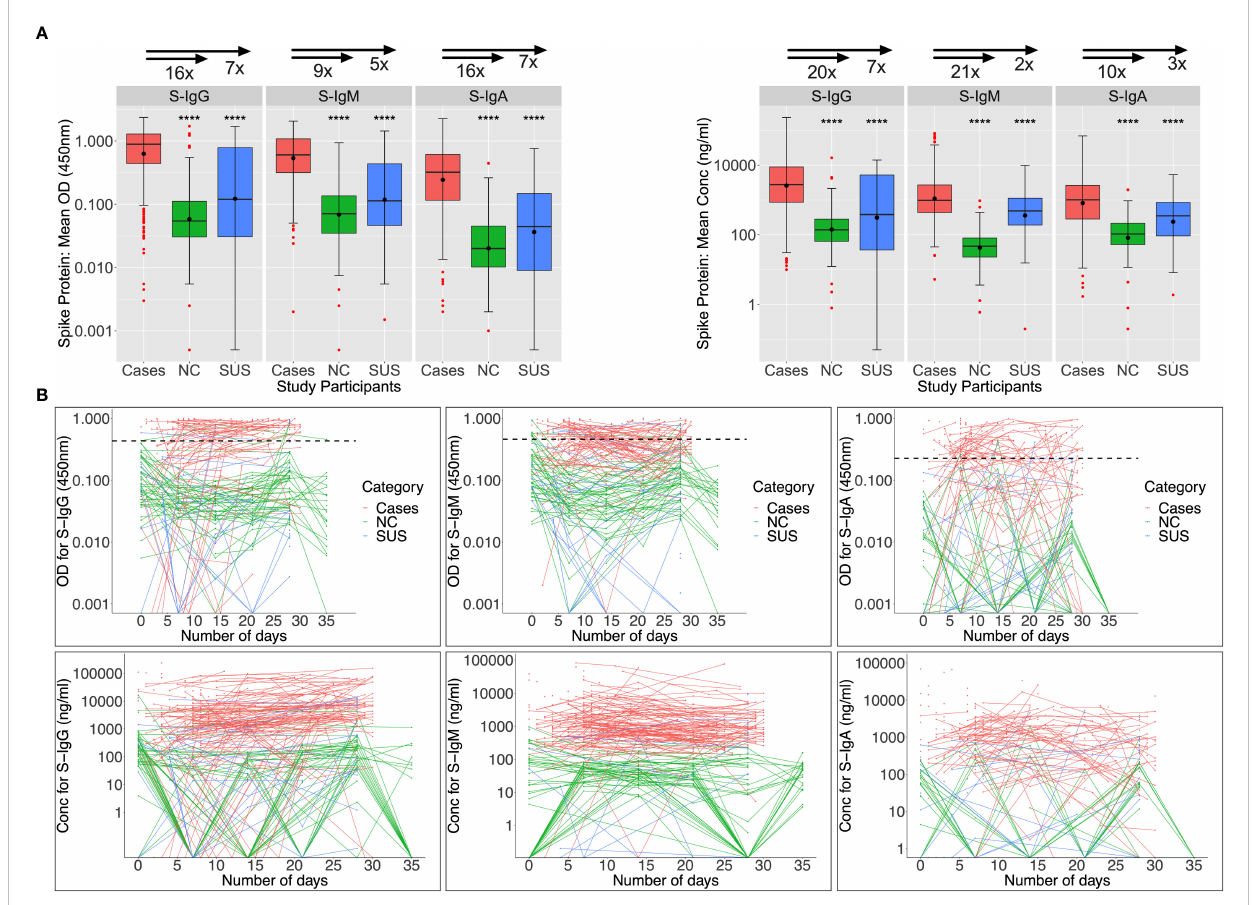
FIGURE 2 Anti-Spike antibody responses during the fi rst month of infection. Individual subject patterns of Spike-directed IgG, IgM, and IgA antibody responses throughout the fi rst 35 days of primary infection are shown in Figure 2. SARS-CoV-2 cases with PCR diagnosis of infection are compared with PCR- negative uninfected contacts (SUS) and non-contacts (NCs). (A) compares medians and interquartile ranges for antibody optical densities at 450 nm and concentrations (ng/ml) among cases, NC, and SUS individuals using box plots and the Kruskal-Wallis test. Pro fi les of spike-directed IgG, IgM, and IgA optical densities and concentrations are shown in (B) as spaghetti plots, with the graphs strati fi ed by exposure and PCR-con fi rmed infection status. P-values less than or equal to 0.05 are regarded as statistically signi fi cant; ∗∗∗∗ p ≤ 0.0001. Optical Density (OD) threshold values for S-IgG, S- IgM, and S-IgA were 0.432, 0.459, and 0.226,